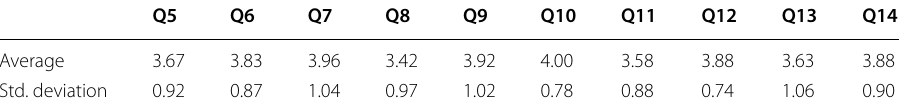
Table 6 Questionnaire